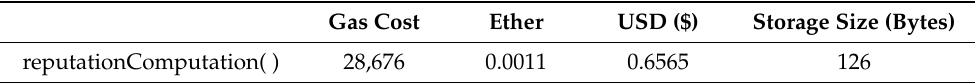
Table 1. [ R 1,3 ] Transaction Resource